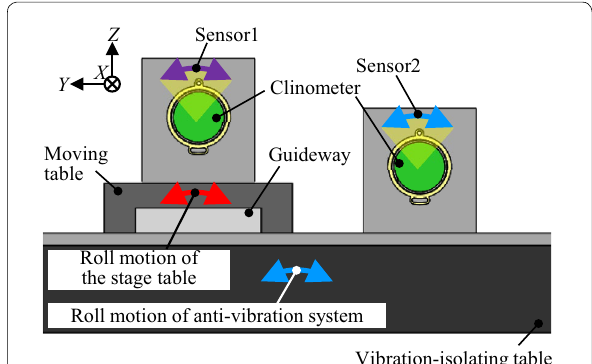
Figure 4 A schematic of the setup for measurement of the roll motion of a linear